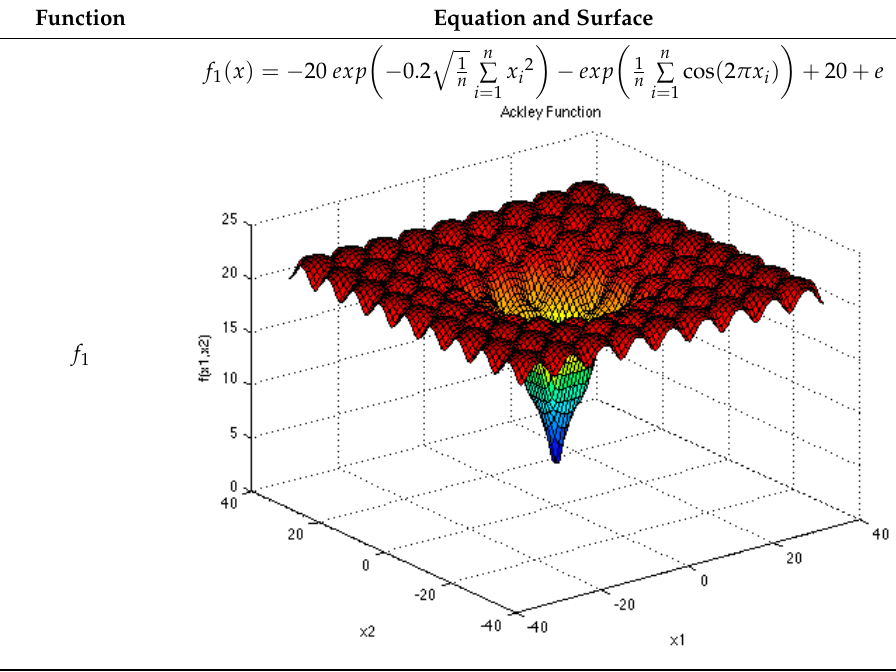
Table 4. Equations and plots of the benchmark functions with optimal values equal to zero. Function